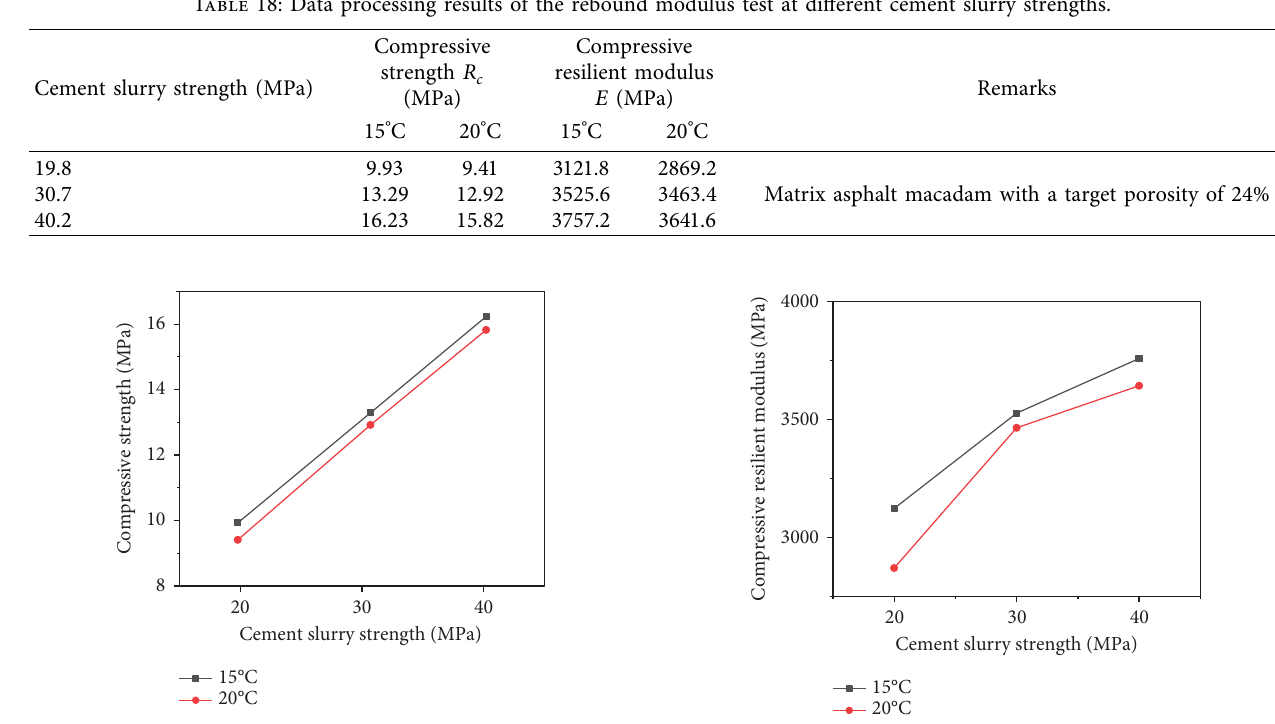
Figure 15: Variation curve of compressive resilient modulus with the cement slurry